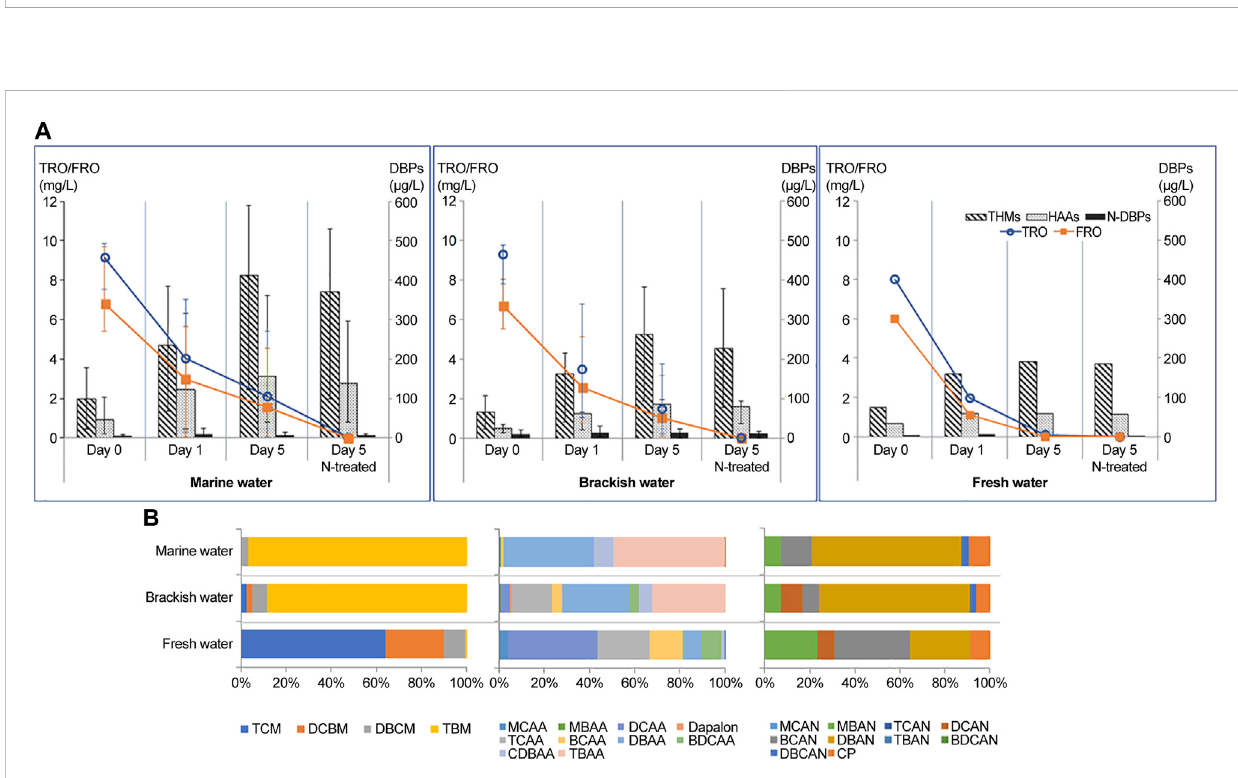
Total concentrations of disinfection byproducts (DBPs) in treated water during various holding periods.